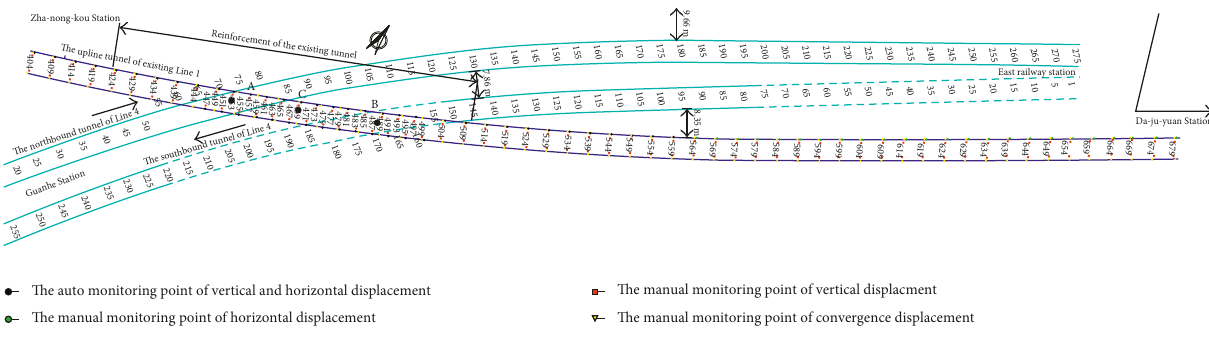
Figure 2: Plan view of tunnel alignment and location of the monitored rings.